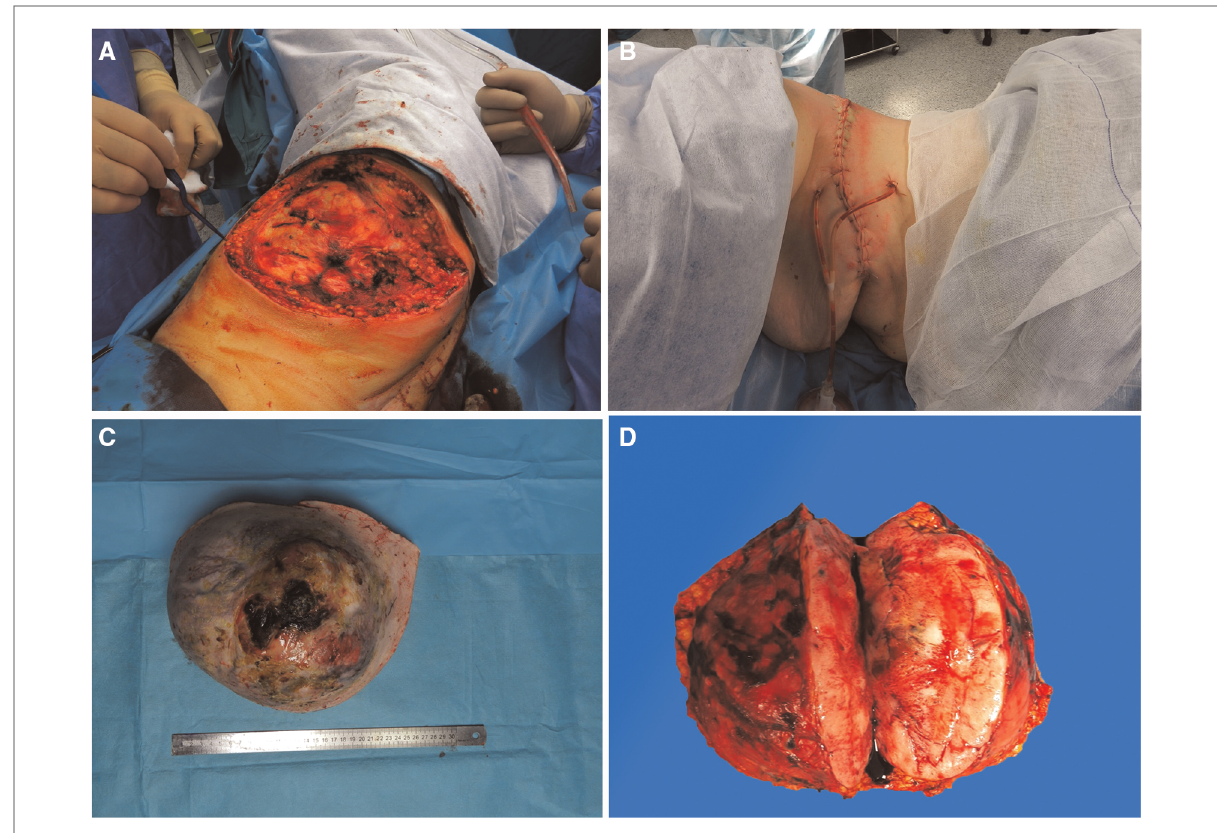
FIGURE 3 Intraoperative and postoperative fi ndings. ( А ). Skin and tissue defects after tumor removal. ( В ). Postoperative view. Gross specimen of the mass. ( C ). Removed tumor. ( D ). The tumor cross